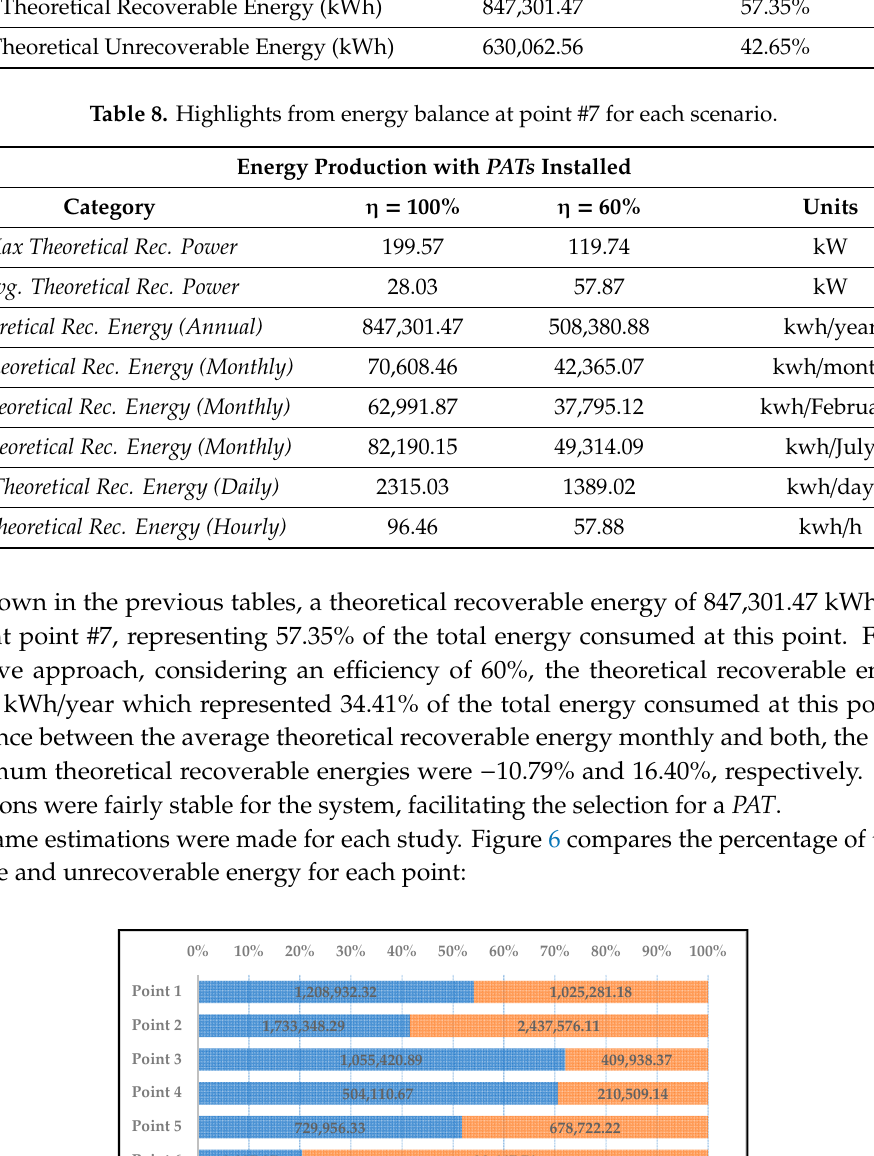
Table 7. Annual energy distribution from point #7.